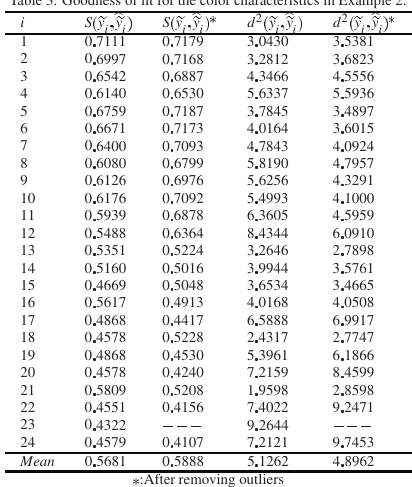
Table 3. Goodness offitforthecolorcharacteristics inExample2.